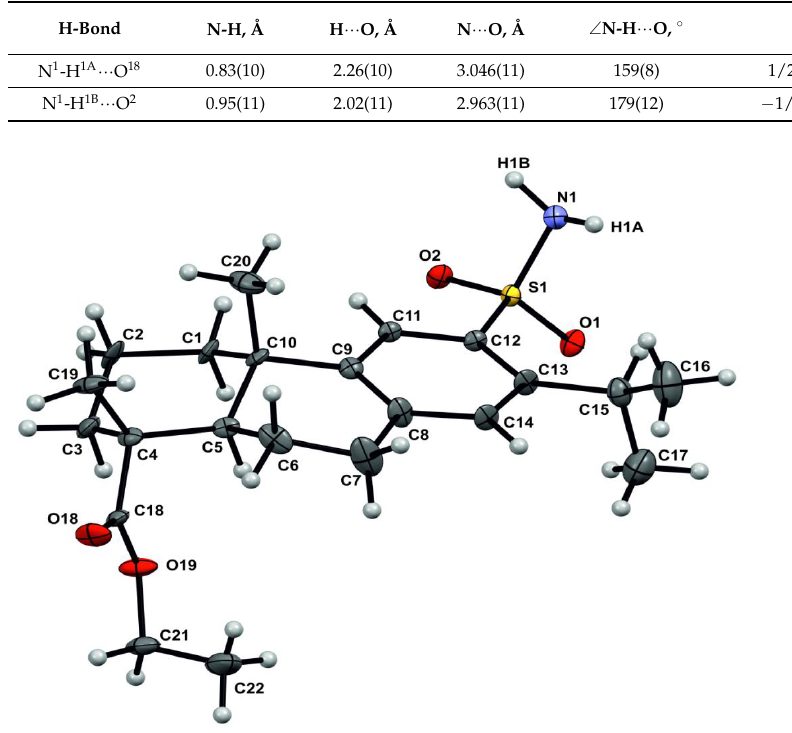
Figure 2. Geometry of molecule 3 in a crystal by X-ray data.